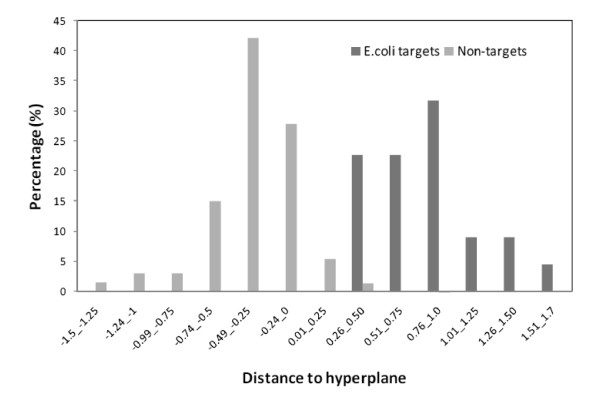
Prediction confidence distributions of E. colitargets and non-targets datasets.